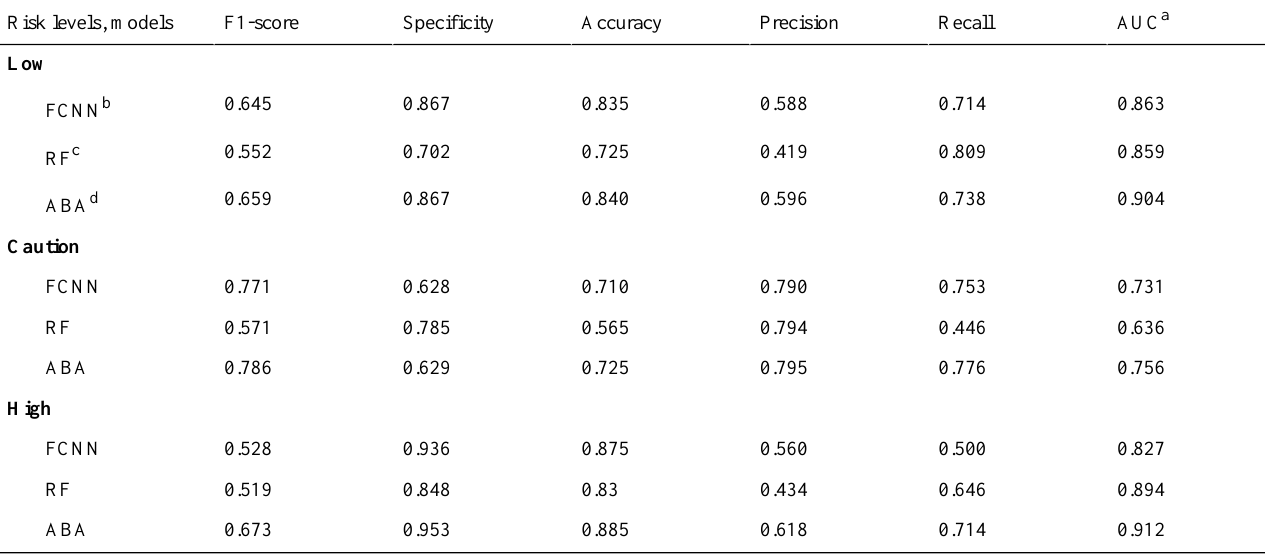
Table 2. Test performance of the abnormal blood pressure data analysis algorithm compared to other